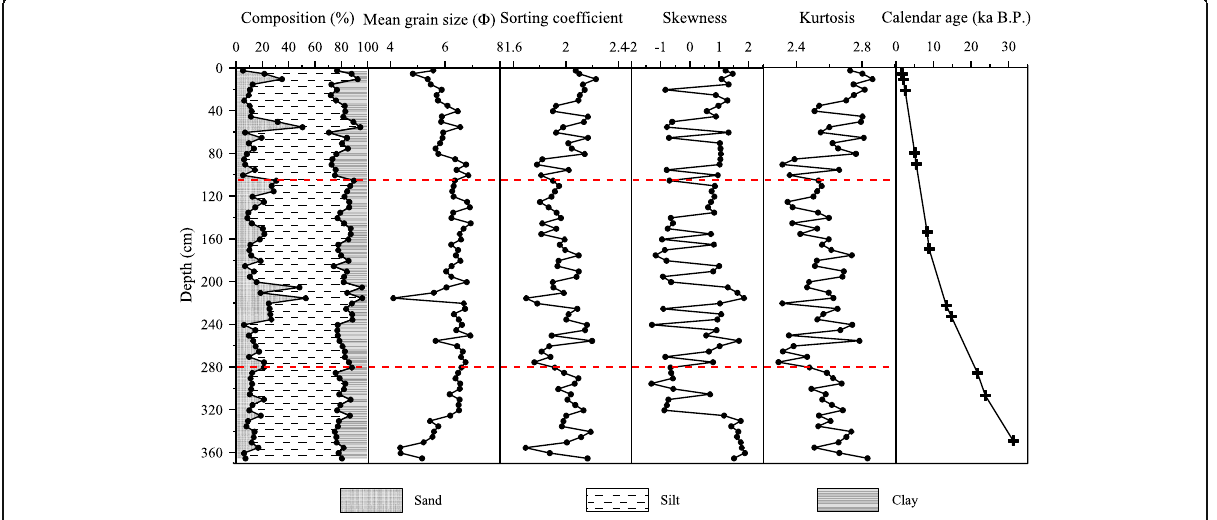
Fig. 2 Vertical distributions of grain size parameters of core SO184-10043; red dashed lines represent the boundary of three